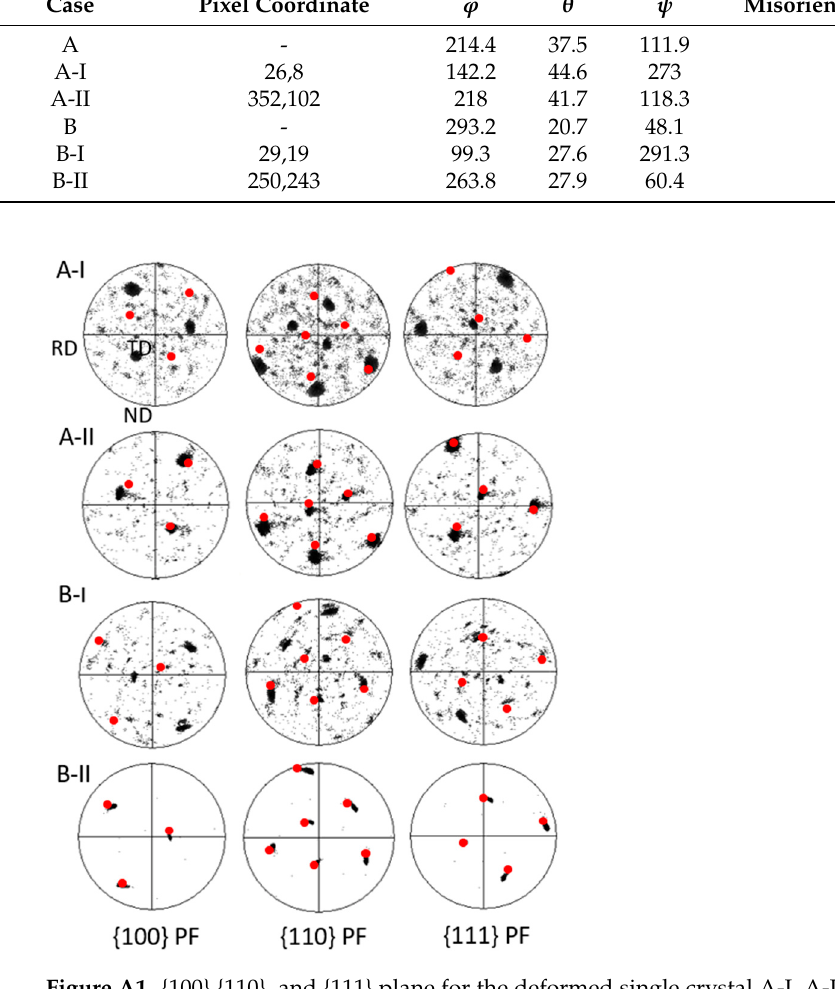
Figure A1. {100} {110}, and {111} plane for the deformed single crystal A-I, A-II, B-I and B-II. Red dots show the orientation for the undeformed sample.